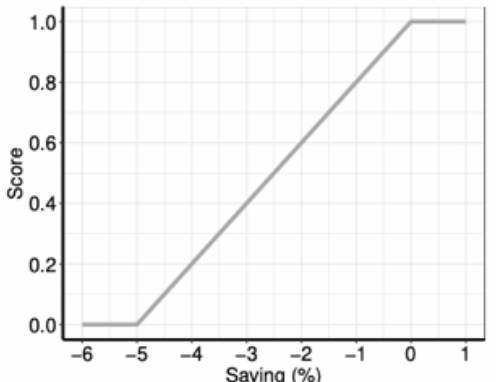
Figure A3. Utility function to calculate the motivation when abandoning practices for committed and environmentalist households. This lineal function maps the water-saving loss (i.e., variation in water use) to a motivation score. If the variation is high, the motivation to abandon the practice is null. If abandoning the practice does not change the demand of water (which is only a theoretical case), it leads to the maximum